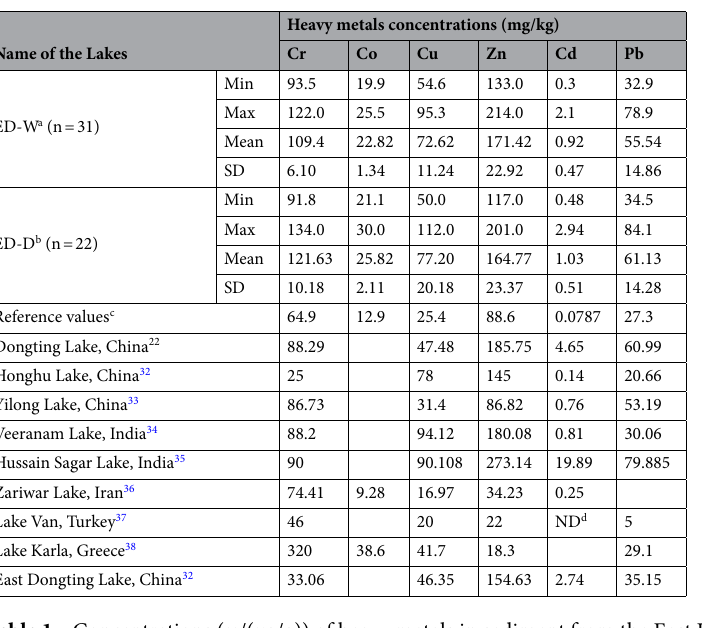
Table 1. Concentrations (ω/(μg/g)) of heavy metals in sediment from the East Dongting Lake in the wet and dry seasons and comparison with other lakes. a East Dongting Lake in the wet season. b East Dongting Lake in the dry season. c Soil background values in Hunan province, China 30 . d Not detected.